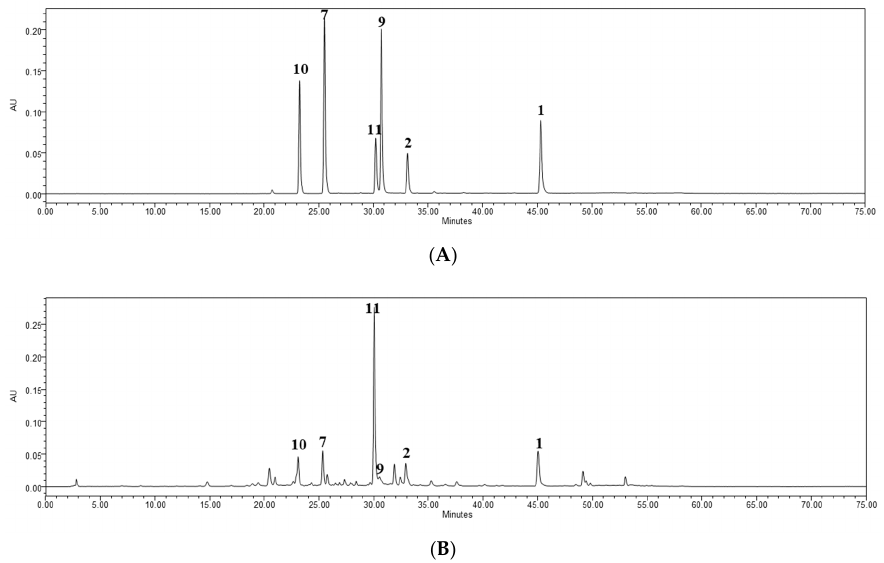
Figure 2. Chromatograms of ( A ) standards mixture and ( B ) T. coreanum ext.